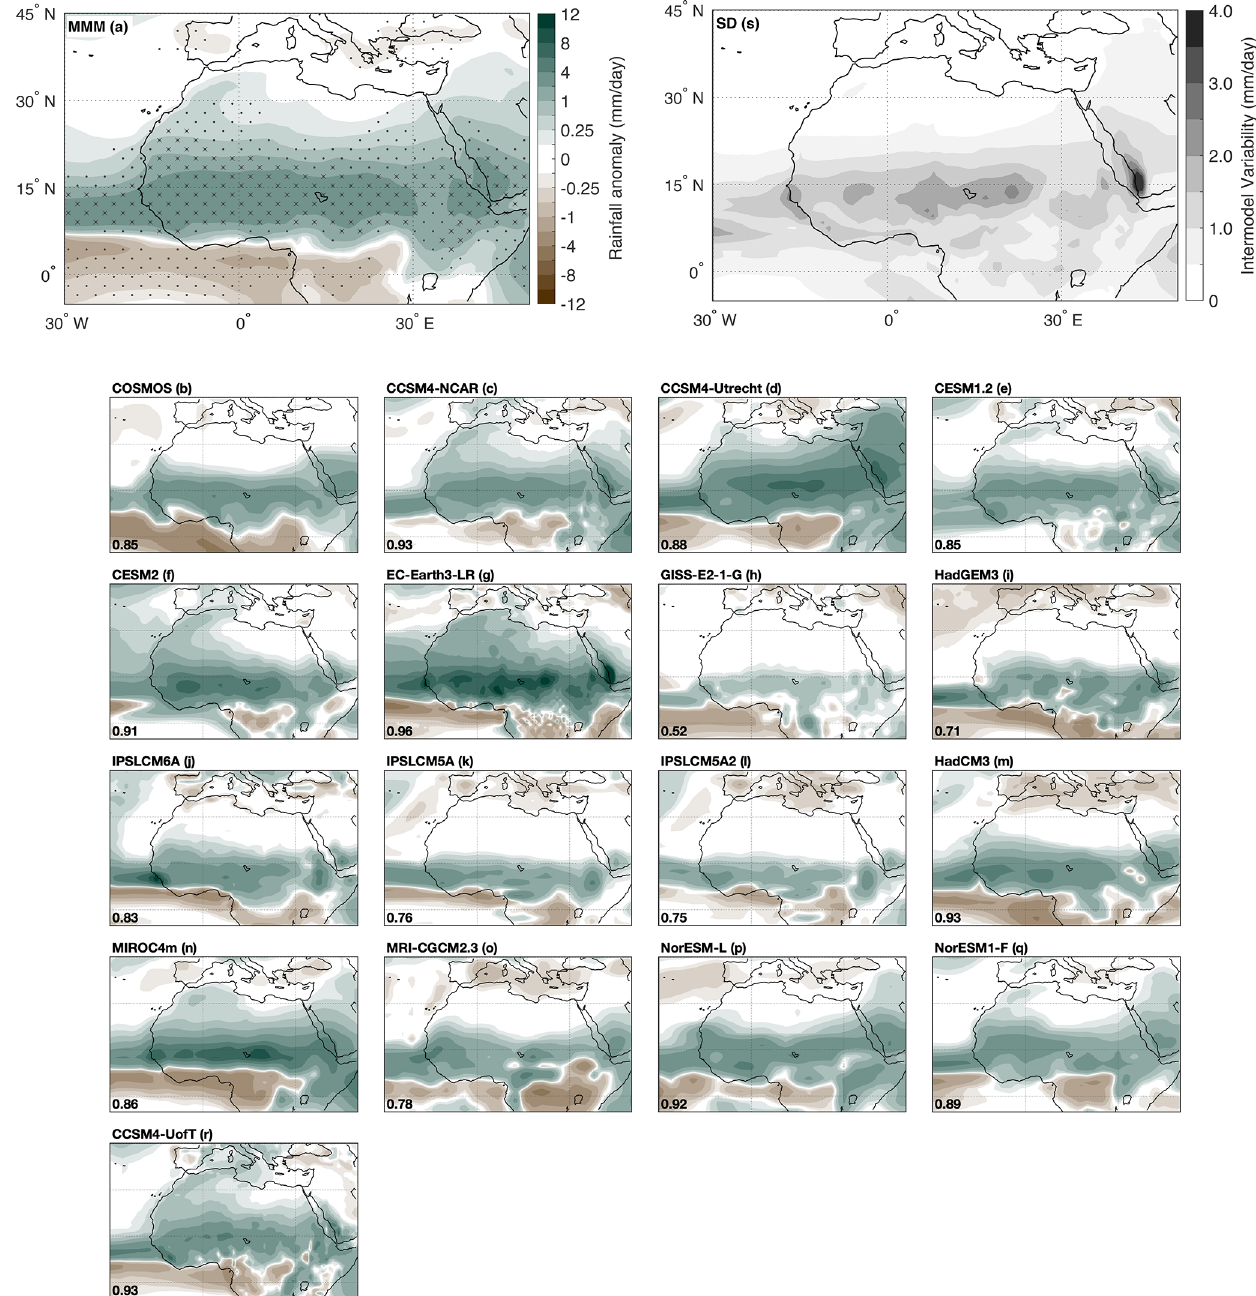
Figure 2. The mPWP July–August–September–October (JASO) rainfall anomalies (mPWP-PI) for the MMM (a) and the individual models (b–r) , with all panels using the same colour bar. Robust signals in (a) are indicated with an x, where > 80% of the models (14 out of 17) show the same sign of anomaly and the anomaly is equal to or larger than the inter-model standard deviation. Dots indicate that only the first criterion is fulfilled. The pattern correlation between the MMM and individual model is seen in the bottom-left corner of (b–r) . (s) The inter-model variability is shown as the standard deviation (unit: